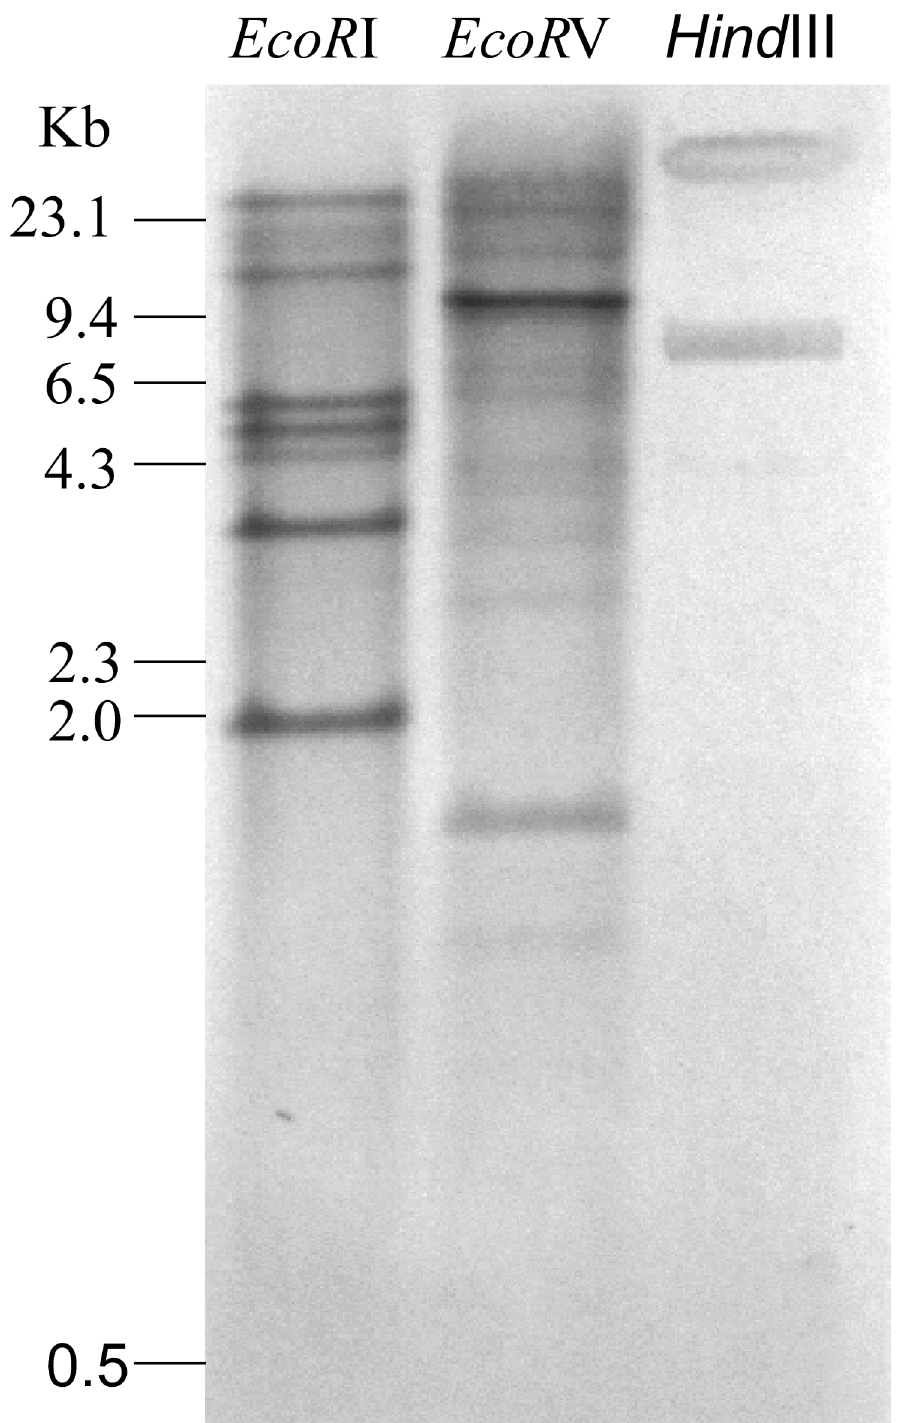
Fig 3. Southern blotting of Hg-pel-6 . Southern blot of the genomic DNA from H . glycines digested with Eco RI, Eco RV and Hind III as well as hybridized with an hg-pel-6 cDNA probe. The DNA size markers are indicated in